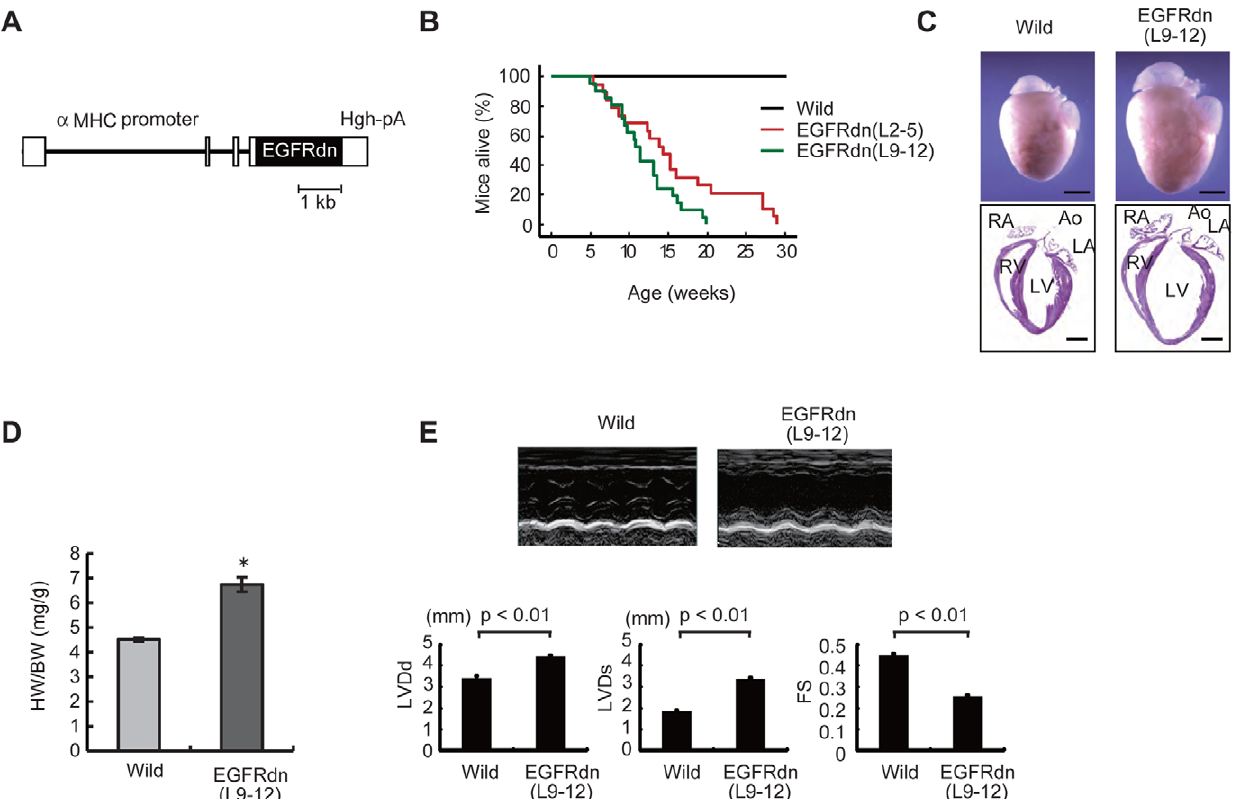
Figure 1. Transgenic overexpression of EGFRdn in the heart causes progressive heart failure. (A) Schematic representation of the cDNA construct used to generate EGFRdn mice. The construct contains an a MHC promoter, human EGFRdn cDNA and a human growth hormone polyadenylation signal (Hgh-pA). (B) Kaplan-Meier survival curves for wild-type ( n =62) and EGFRdn (L2–5, n =19; L9–12, n =21) mice, showing a significant reduction in the survival rates in EGFRdn mice (log rank test, P , 0.0001). (C) Gross morphology of whole hearts (upper panels) and longitudinal sections (lower panels) of hearts from wild-type and EGFRdn mice (L9–12) at 6 weeks of age. Ao, aorta; LA, left atrium; LV, left ventricle; RA, right atrium; RV, right ventricle. Scale bars: 2 mm. (D) Heart-to-body weight ratios (HW/BW) of wild-type ( n =9) and EGFRdn (L9–12, n =7) mice at 6 weeks of age. * P , 0.01. (E) Echocardiographic analysis. The upper photographs show representative M-mode images. The lower graphs show the left ventricular diastolic and systolic dimensions and FS of 8 week-old EGFRdn mice (L9–12) ( n =23) and age-matched wild-type mice ( n =10). LVDd, left ventricular diastolic dimension; LVDs, left ventricular systolic dimension. Data are means 6 s.e.m.